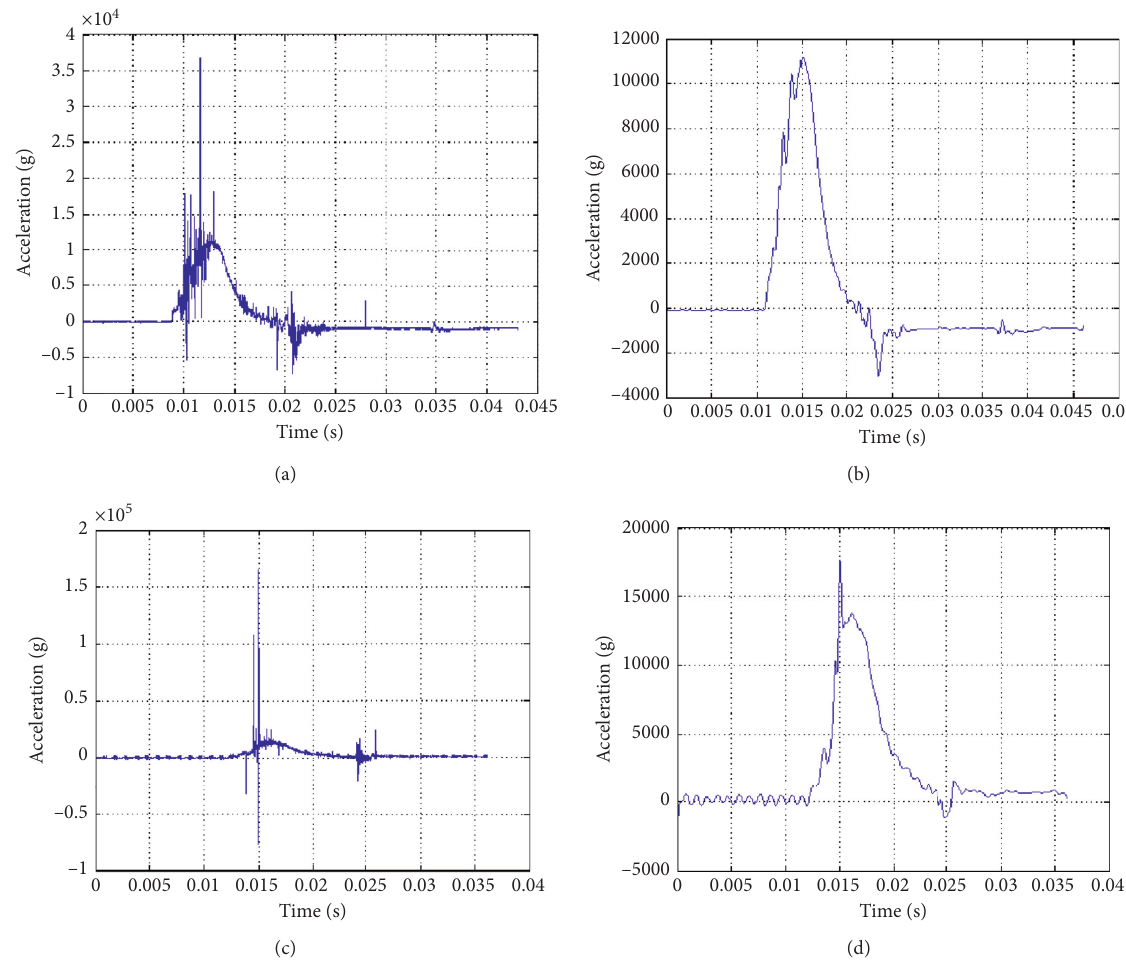
Figure 15: Waveform chart in launching process: (a) the original signal collected by acceleration sensor 1#; (b) the filtered signal collected by acceleration sensor 1#; (c) the original signal collected by acceleration sensor 2#; (d) the filtered signal collected by acceleration sensor 2#.